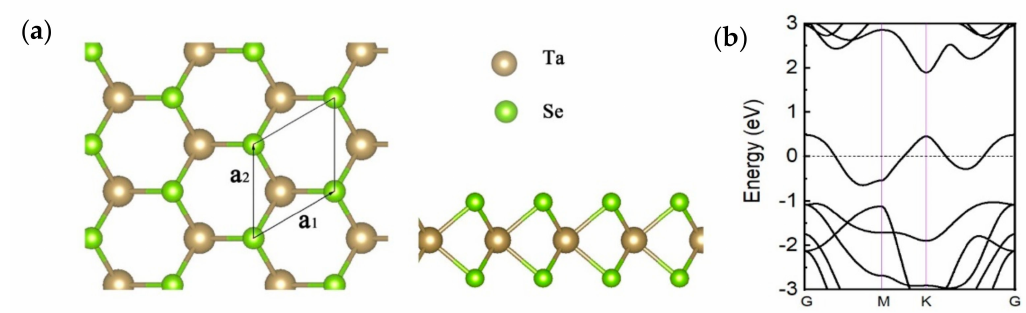
Figure 1. ( a ) Top (left) and side (right) view of monolayer TaSe 2 and ( b ) band structures of monolayer TaSe 2 . Fermi level is set to 0 eV. G (0, 0, 0), M (0.5, 0, 0), and K (0.333333, 0.333333, 0) represent highly symmetric points in the reciprocal